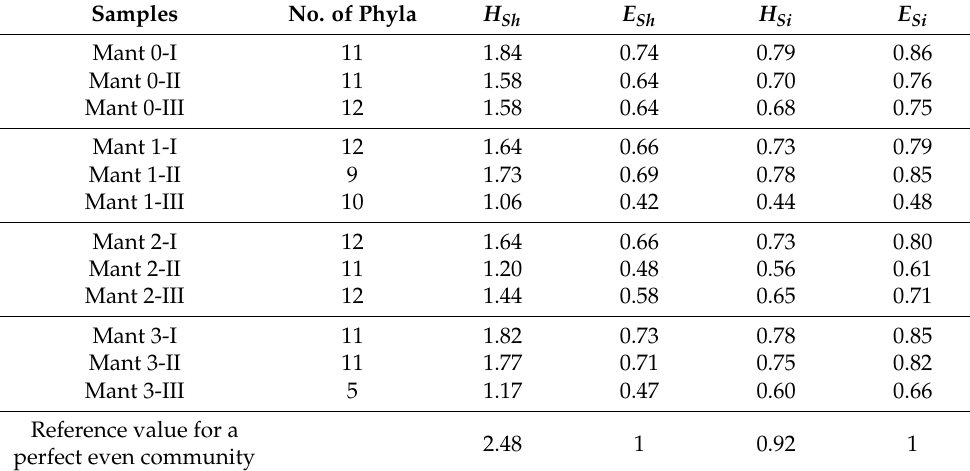
Table 3. Quantitative data analysis of bacterial phyla (alpha